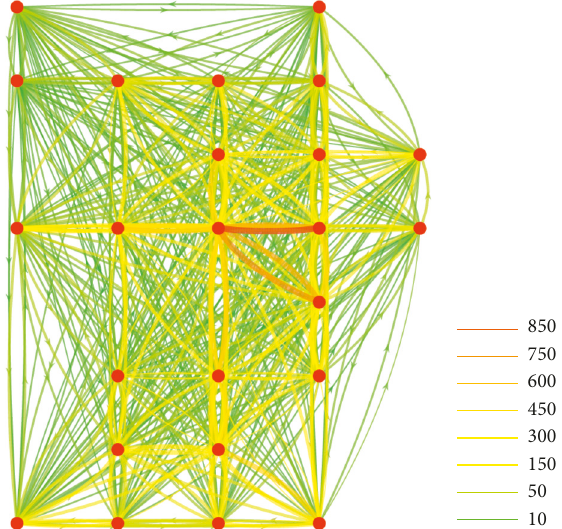
Figure 15: Equilibrium ride-sourcing trip flow between each show that most trip orders are achieved around the upper- right CBD area. Fewer trips are achieved on long-distance O-D pairs due to the higher in-vehicle time cost. The mean driver idle time on all O-D pairs is 0.790 hr. 37.4% of the drivers experience driver idle time less than 10 min, 24.1% of them experience driver idle time between 10 and 30 min, and the remaining 38.5% experience more than 30 min before service. The mean passenger waiting time on all O-D pairs is 0.057 hr. Only 44.3% of the passengers